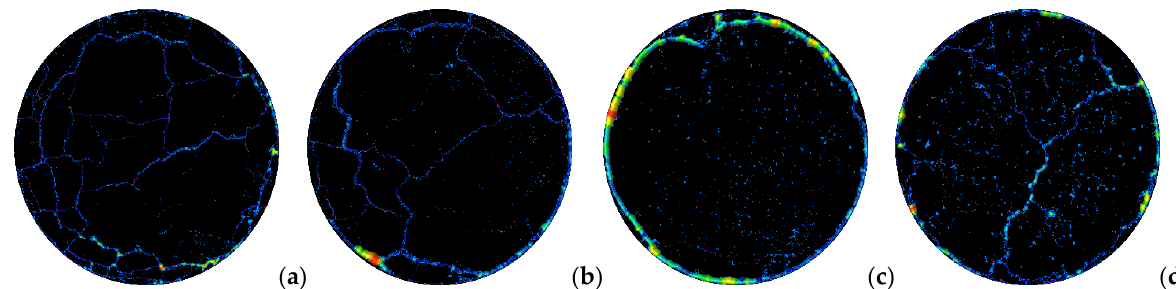
Figure 16. The dry density of 1.3 g/cm 3 : ( a ) 0.25 mm; ( b ) 0.50 mm; ( c ) 2.00 mm; ( d ) 5.00 mm.